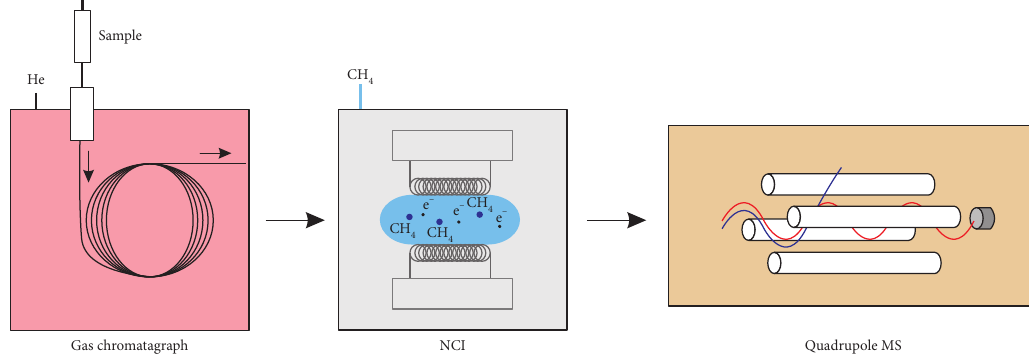
Figure 1: Schematic setup of the GC-NCI-qMS device, equipped with a gas chromatograph (GC), negative chemical ionization (NCI), and quadrupole mass spectrometry